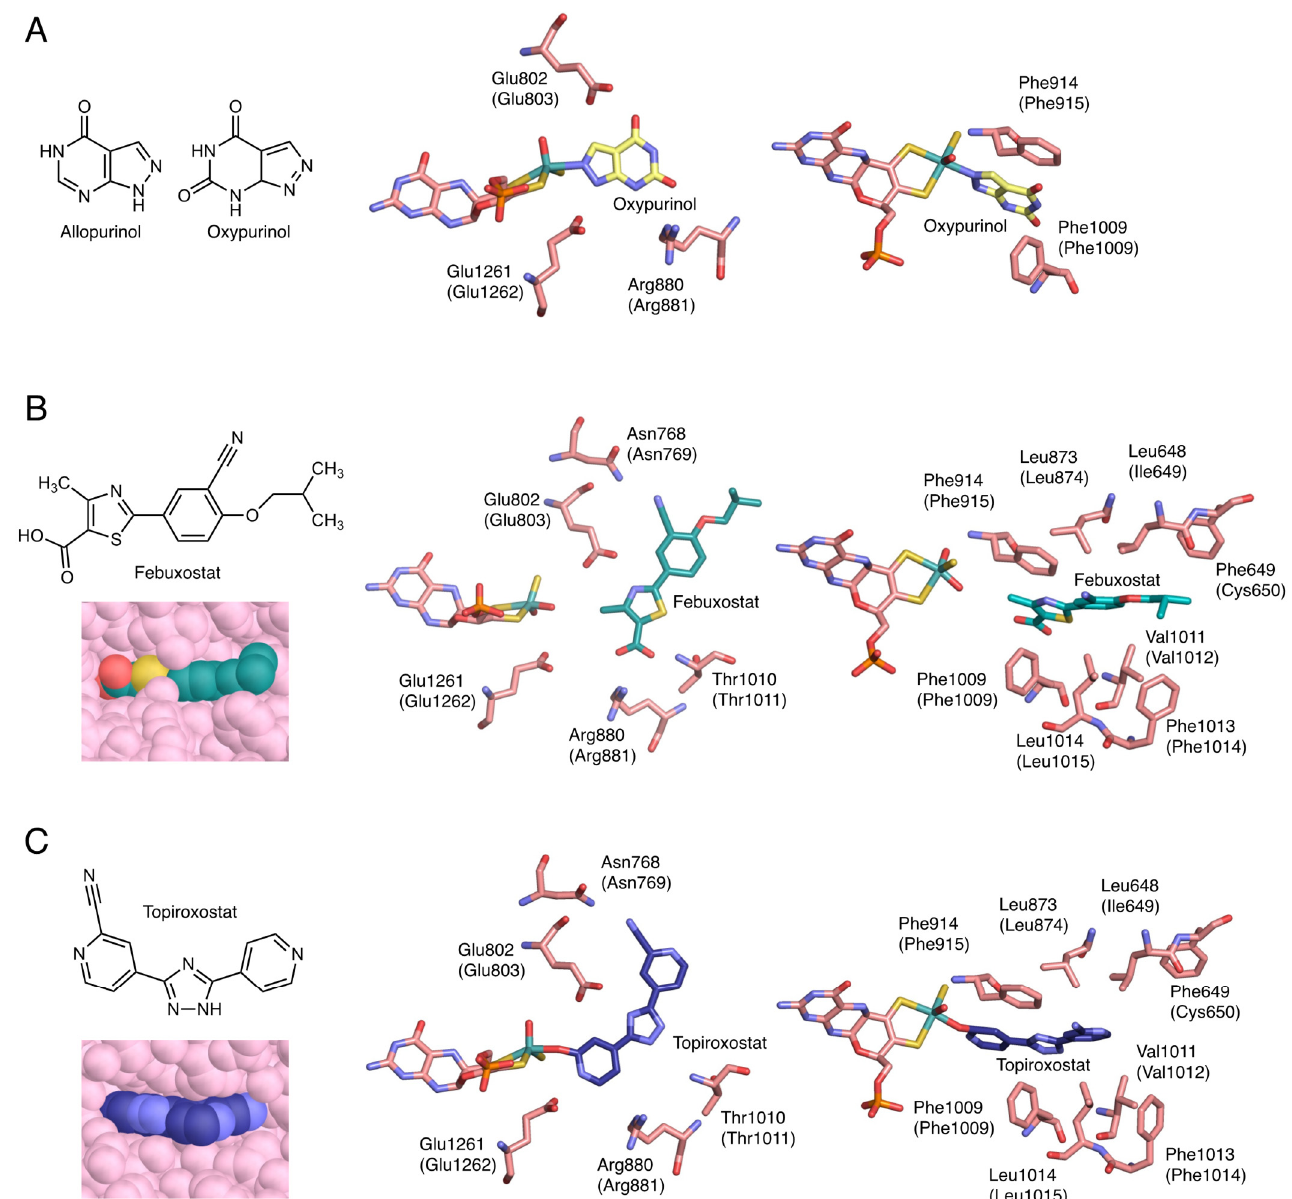
Figure 4. Crystal structure of inhibitors bound to bovine XOR. Human sequences are shown in parentheses. ( A ) Chemical structures of allopurinol and oxypurinol, and the interactions of oxypurinol with surrounding amino acid residues (PDB ID: 3BDJ). ( B ) Chemical structure of febuxostat and the interactions of febuxostat with surrounding amino acid residues and space-filling model (PDB ID: 1N5X). ( C ) Chemical structure of topiroxostat and the interactions of topiroxostat with surrounding amino acid residues and space-filling model (PDB ID: 1V97).